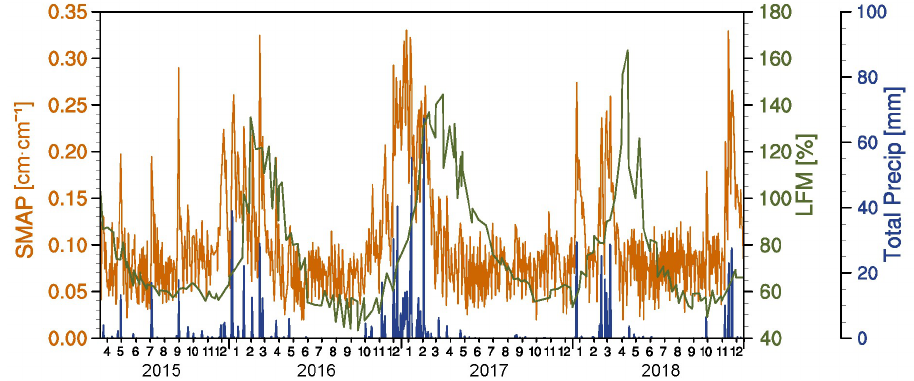
Figure 3. Averaged SMAP soil moisture (SM) from AM overpasses, chamise LFM observation, and the Parameter-elevation Relationships on Independent Slopes Model (PRISM) daily precipitation across 12 sites of Southern California used in the study. Orange lines are the averaged SMAP SM. Green lines are the averaged LFM observations. Blue bars are the daily precipitation derived from PRISM climate dataset.